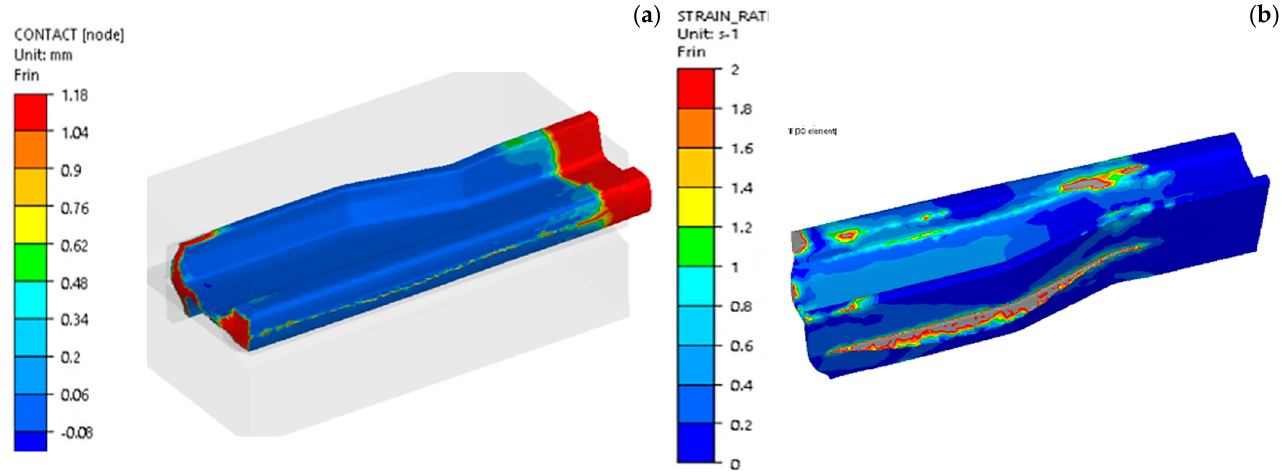
Figure 6. Results of the FEM simulation: ( a ) contact for forging after III, the final forging operation, ( b ) the mean deformation rate.